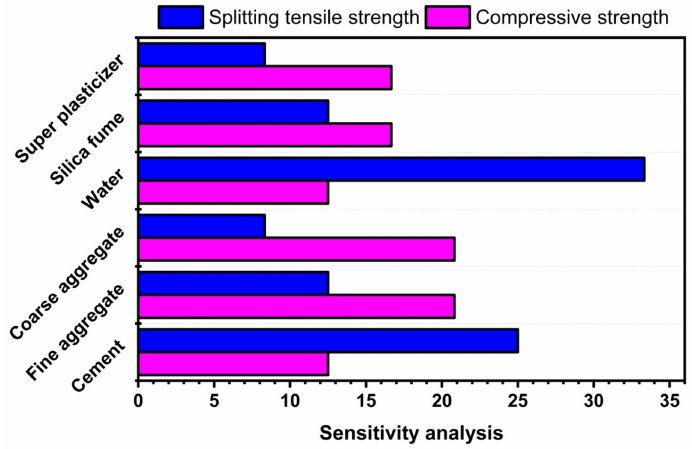
Figure 15. Contribution of input parameters to compressive and splitting tensile